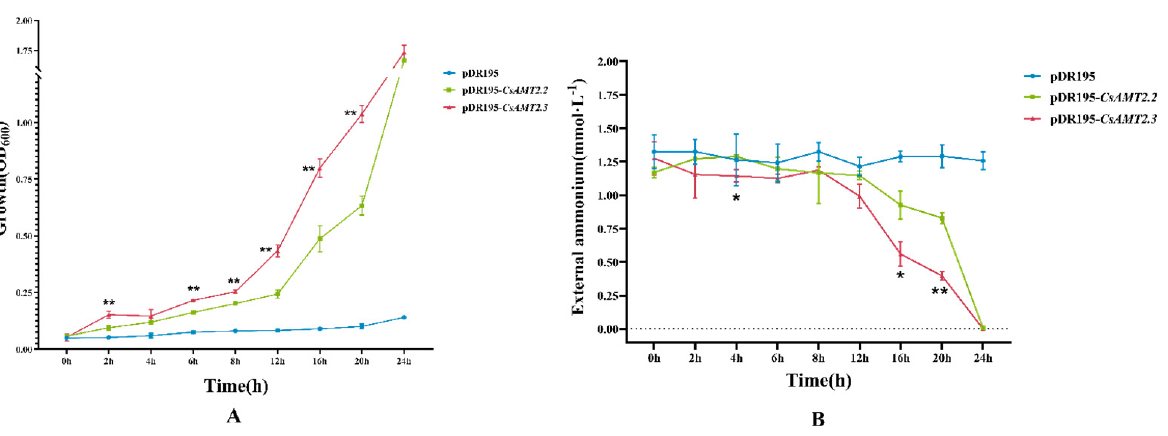
Figure 8. Functional growth complementation analysis of CsAMT2s in ammonium-uptake-defective yeast mutant.